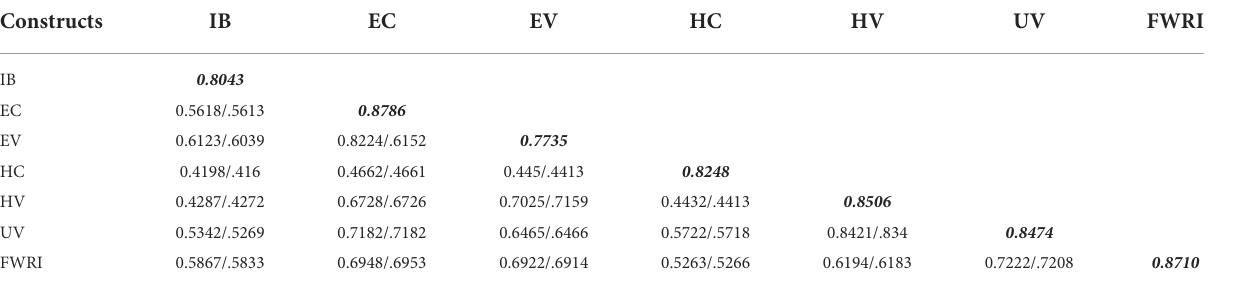
TABLE 3 Results of discriminant validity heterotrait–monotrait